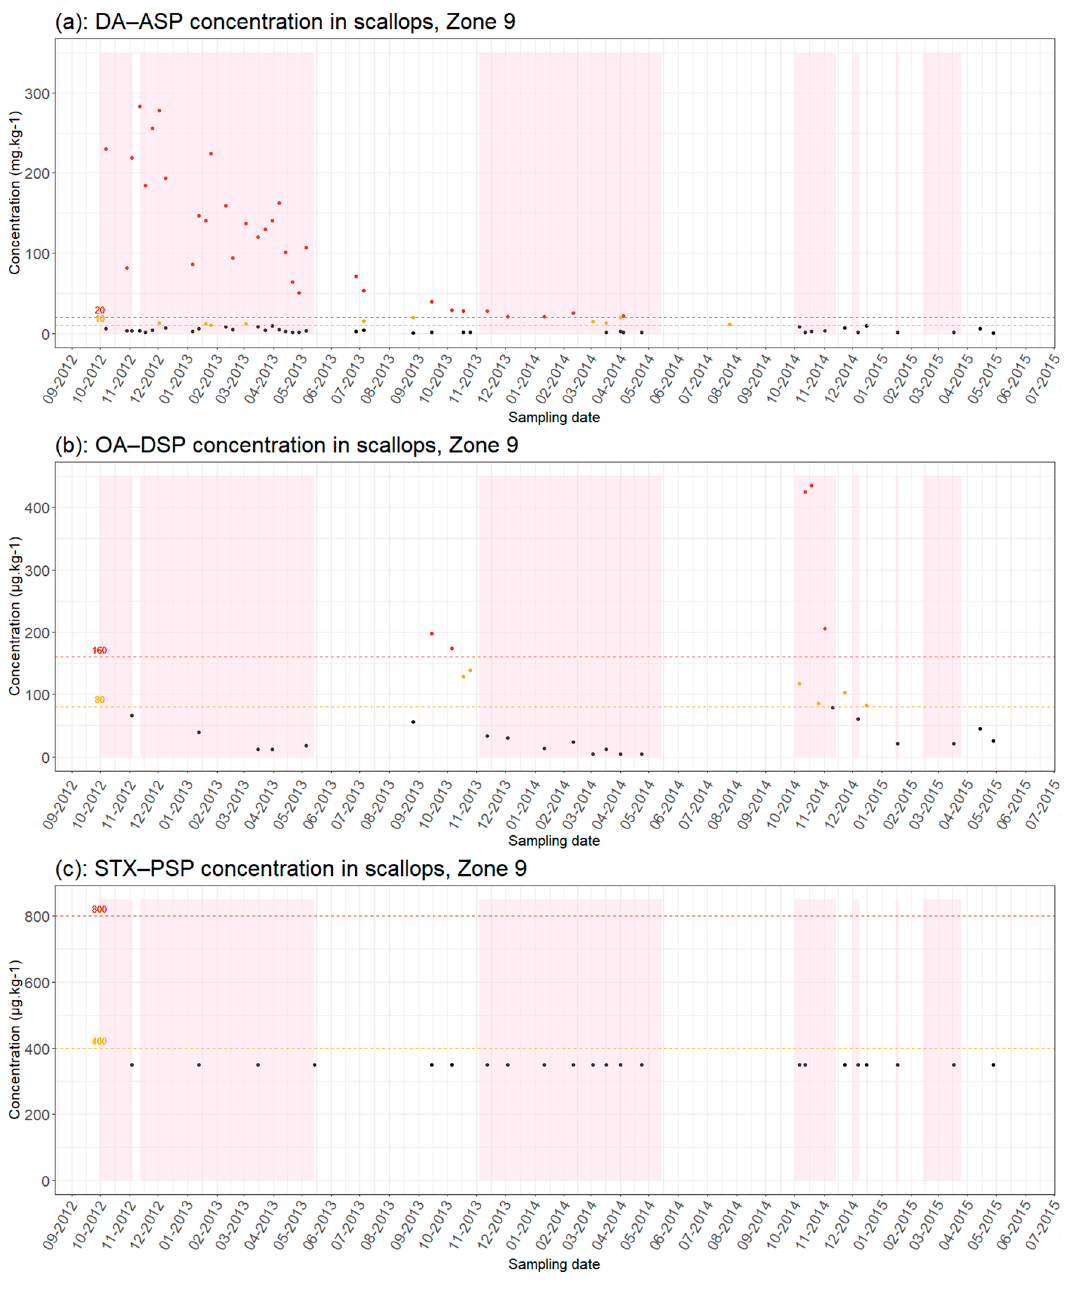
Figure 3. Results of phycotoxin analyses in scallops ( a ) [DA(Domoic Acid) − ASP, ( b ) OA(Okadaic Acid) − DSP and ( c ) SXT (Saxitoxins) − PSP] from production areas 9 from September 2012 to July 2015: Red dots = results > regulatory thresholds; orange dots = results > half regulatory threshold; black dots = results below regulatory threshold; pink background color = closure periods; red dotted line = regulatory toxicity threshold; orange dotted line = half toxicity threshold.